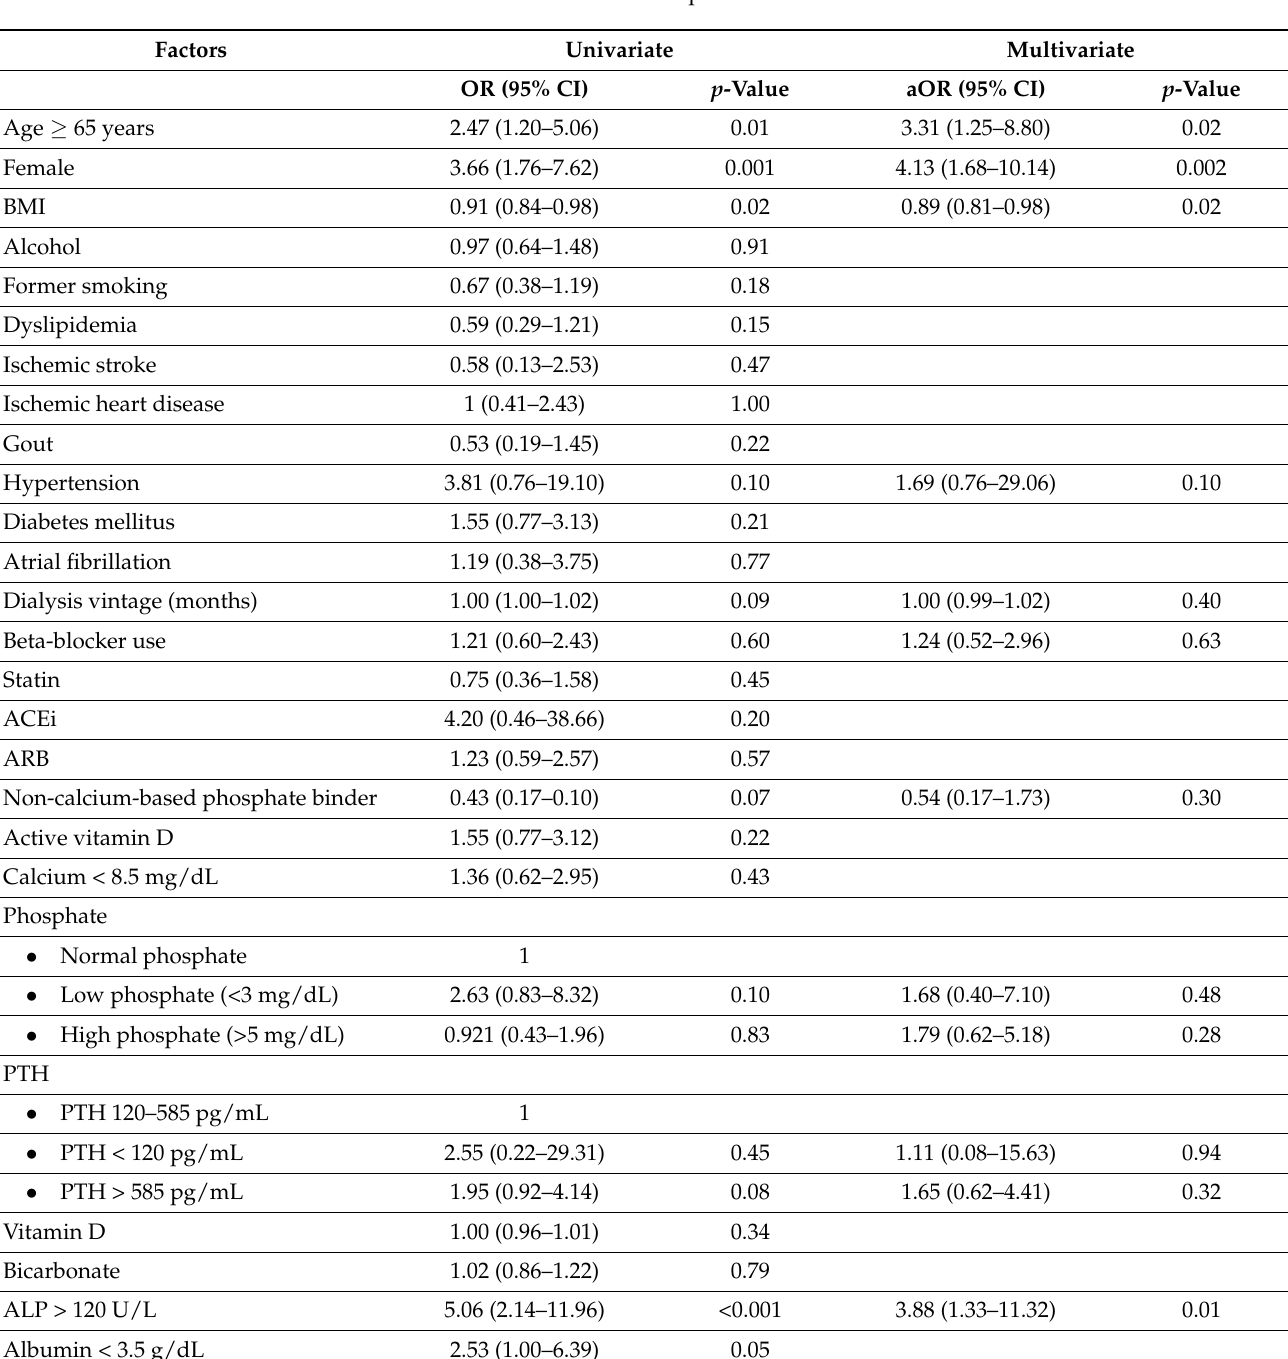
Table 6. Associated factors with